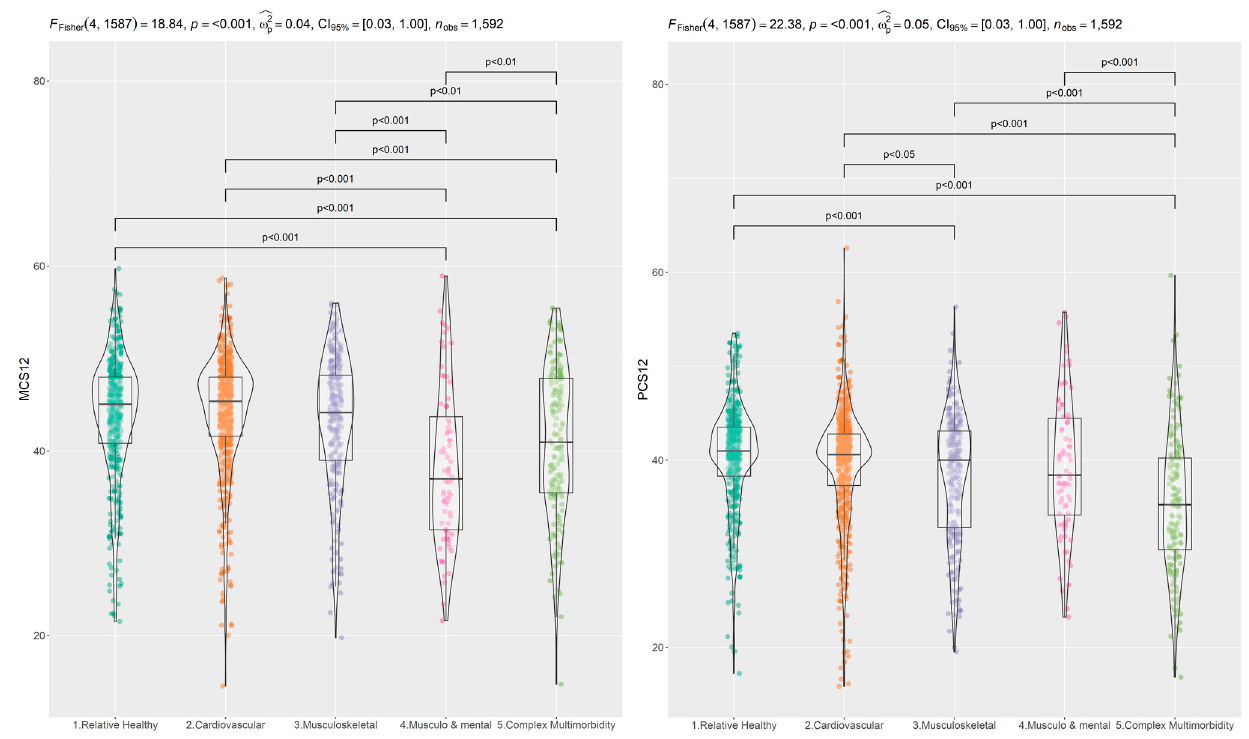
Figure 3. Boxplot of SF-12 dimensions among patterns and ANOVA test and a posteriori comparison in each dimension. MCS: Mental Component Score, PCS: Physical Component Score.